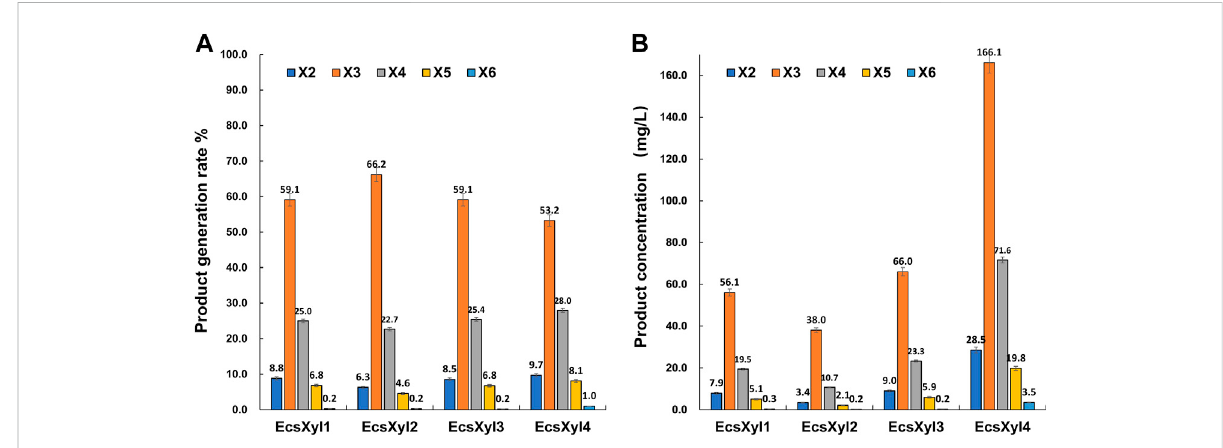
FIGURE 7 HPLC result analysis of the hydrolystaes broken down into beechwood xylan by EcsXyl1 – EcsXyl4 at pH 9.0 and 55 ° C for 30 min. (A) : Product generation rate; (B) : Product